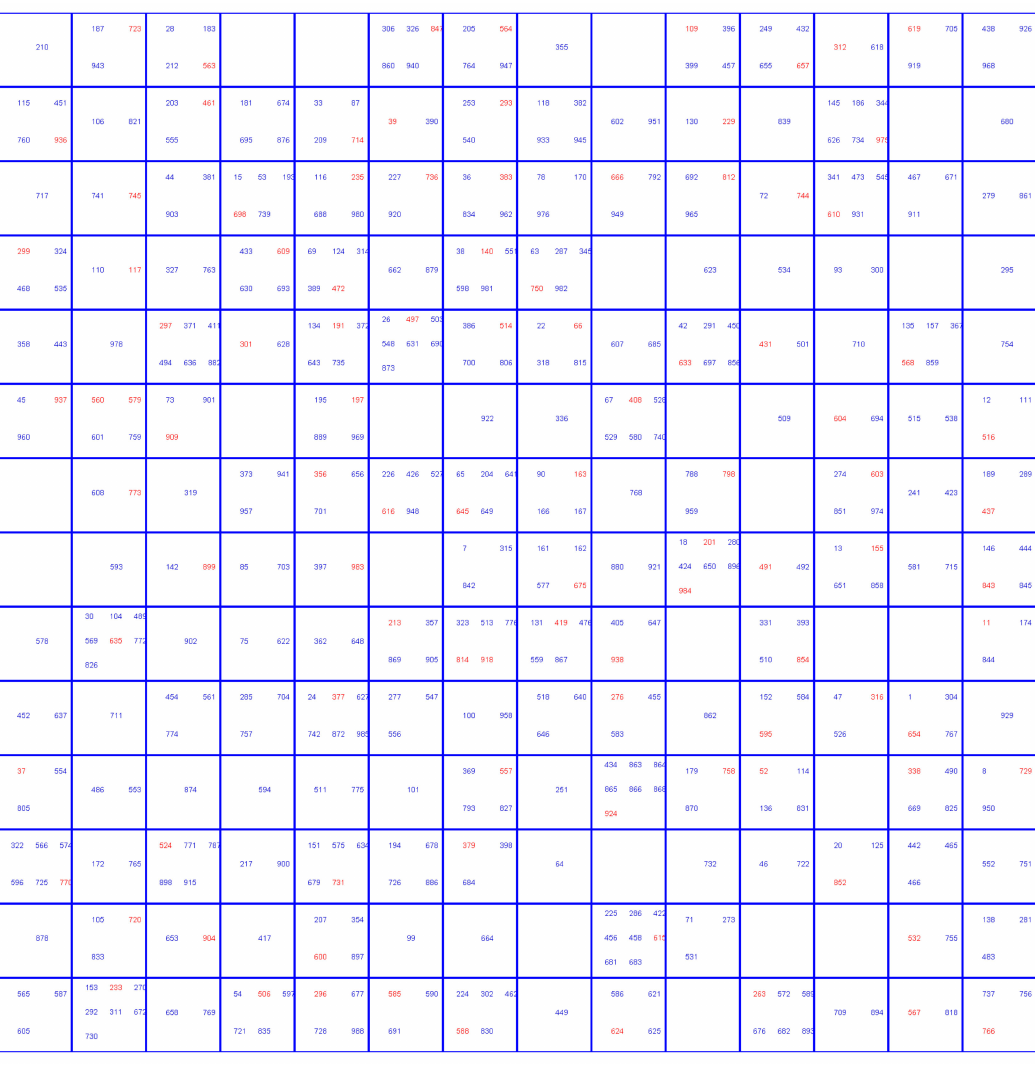
Figure 2. Selection of validation set compounds for the first approach using the Kohonen